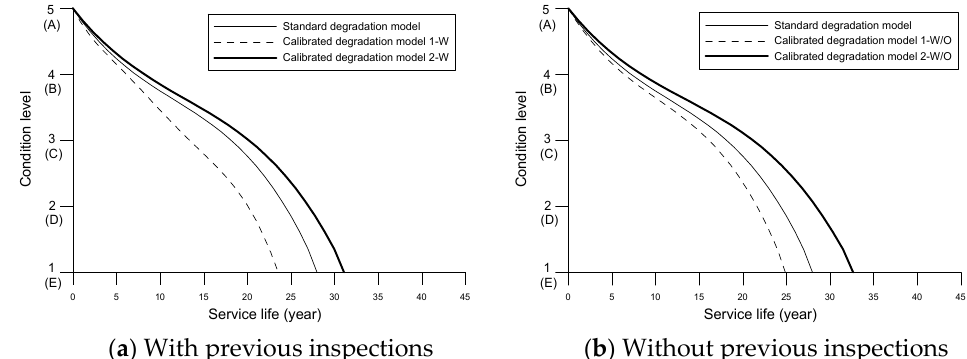
Figure 6. Calibration of the performance degradation model of the RC slab.